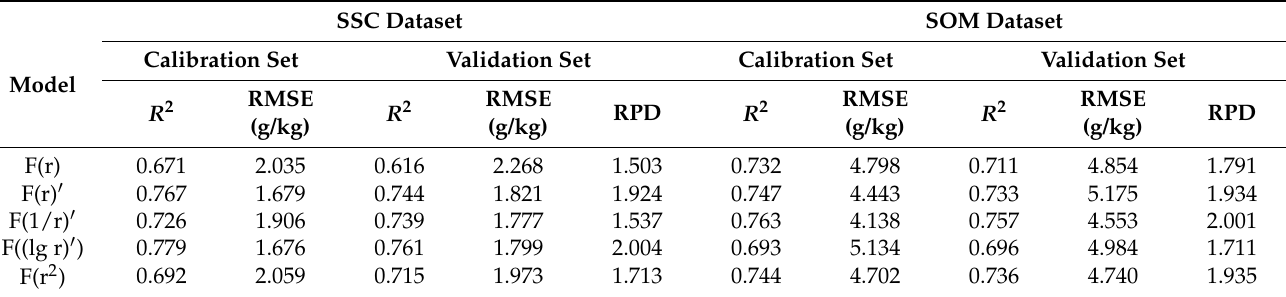
Table 5. SSC and SOM hyperspectral estimation models.